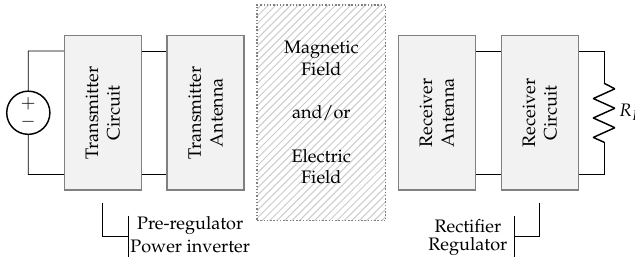
Figure 2. Structure of a coupled wireless power transfer